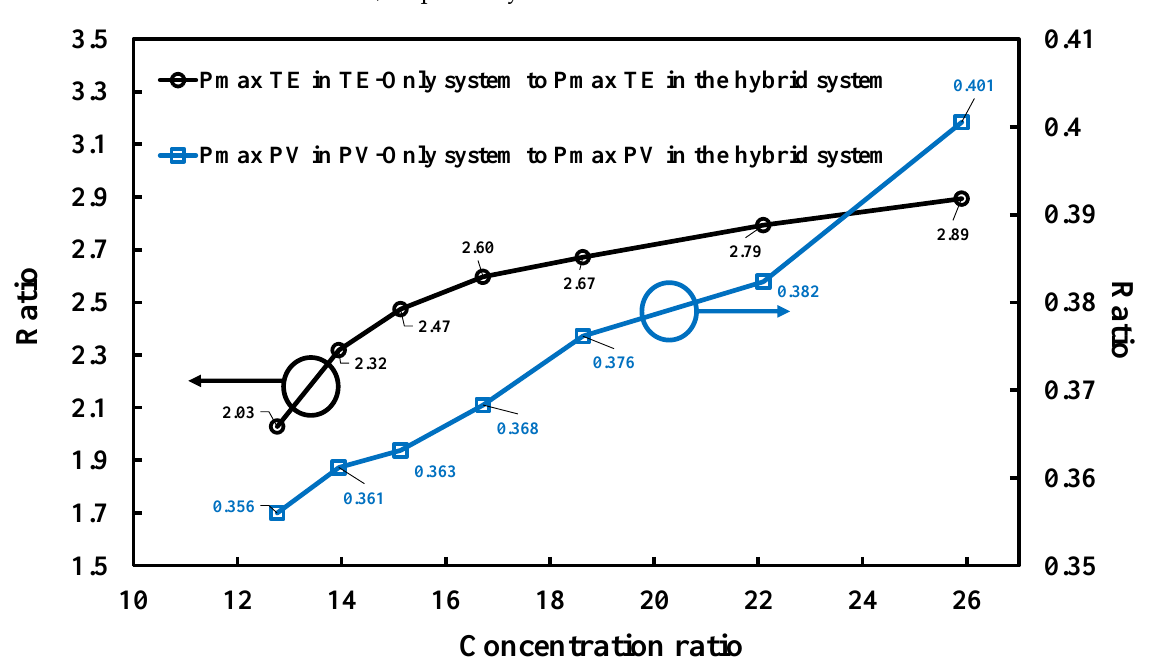
Figure 8. Ratio of power generation by the PV cell and TE module in the PV-only and TE-only systems over the TE-PV-BS